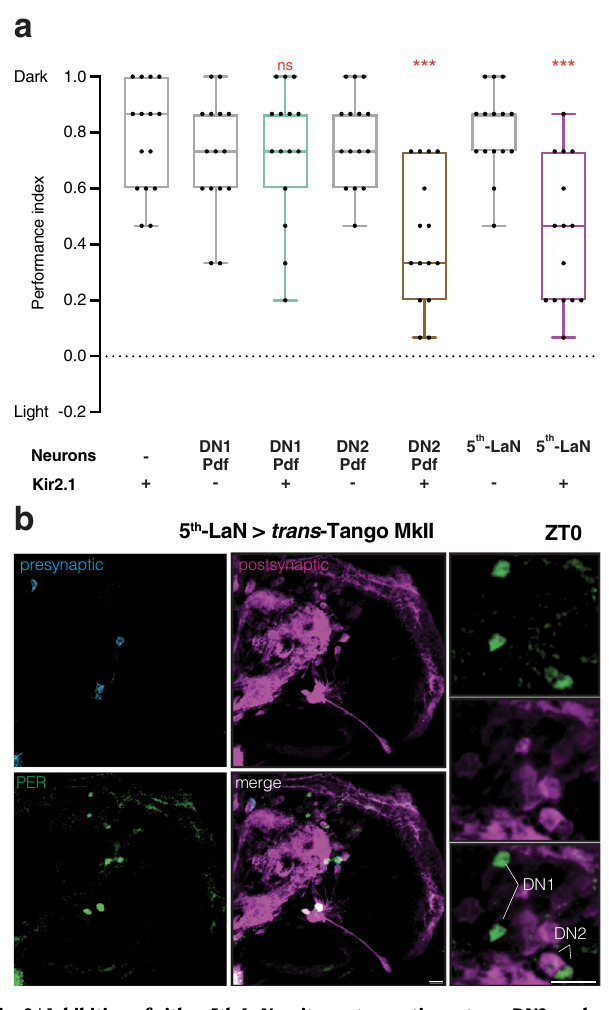
Fig. 3 | Inhibition of either 5th-LaN or its postsynaptic partners DN2s reduces light avoidance. a The effect of Kir2.1-mediated silencing of clock neuron subsets on lightavoidanceat550 lux.Silencing of the5th-LaN or DN2s&Pdf-LaNs results in defective photophobia, whereas silencing of DN1s&Pdf-LaNs has no effect. Box- plots indicate median (middle line), 25th and 75th percentile (box), bars represent maximum and minimum. One-way ANOVA, ns: not signi fi cant, *** p <0.001. n =15 trials for each group. b DN2s but not DN1s receive direct synaptic input from the 5th-LaN as revealed by PER staining in ZT0. Presynaptic GFP (cyan), postsynaptic mtdTomato-HA (magenta) and PER (green). Scale bars, 10 μ m. Source data are provided as a Source Data fi